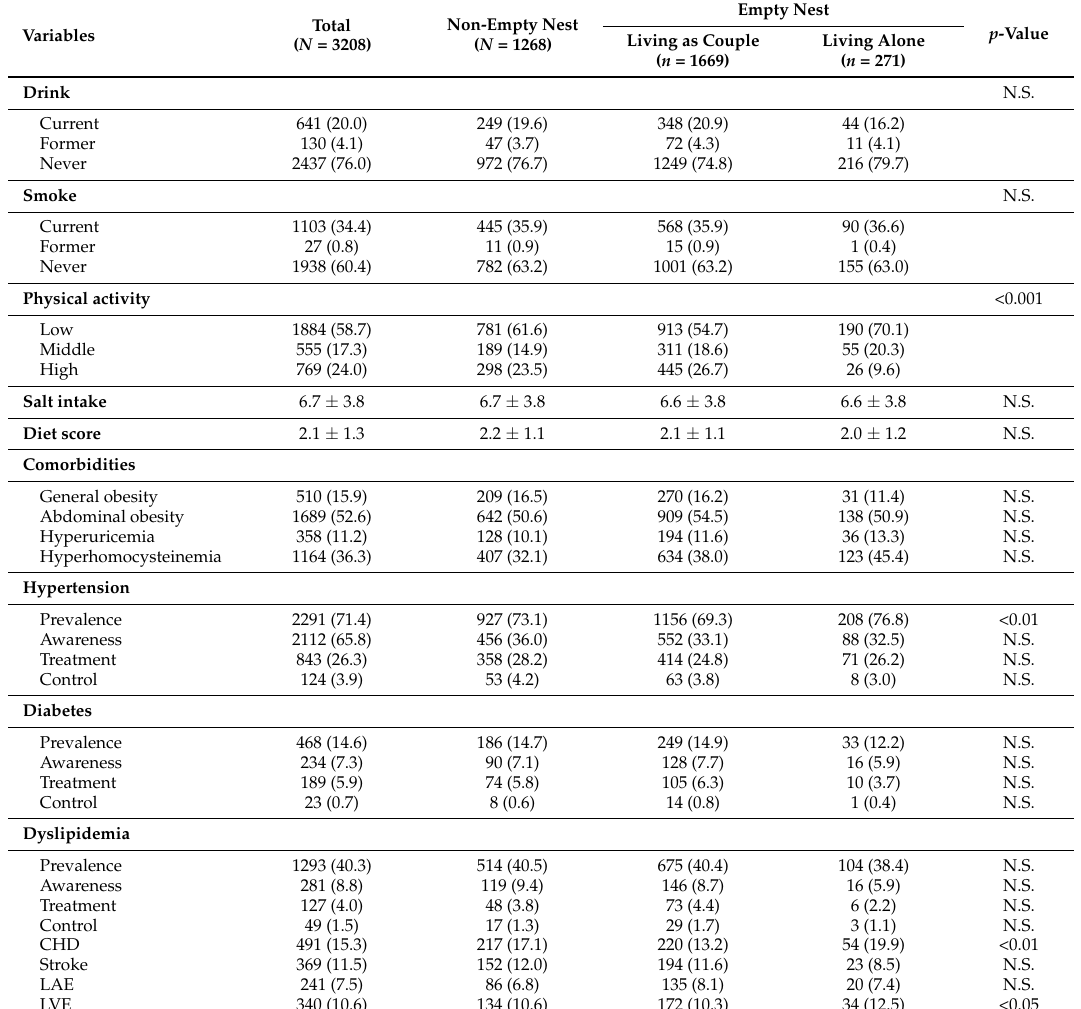
Table 2. Lifestyles and comorbidities among